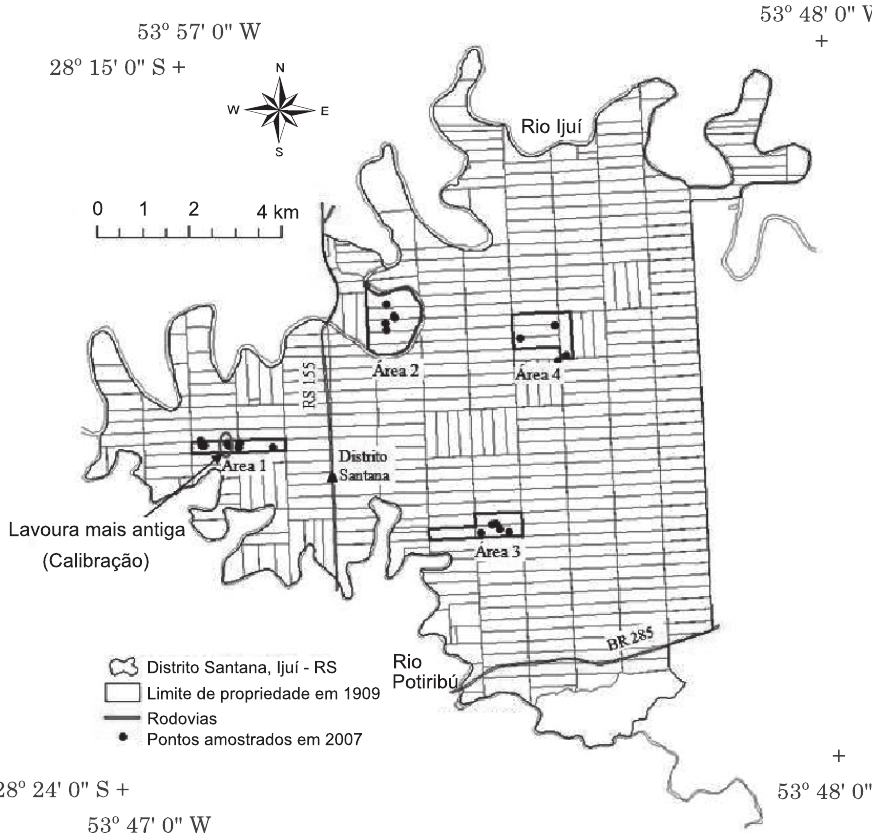
Figura 1. localização do distrito santana, ijuí – rs, e a distribuição espacial dos pontos amostrados em quatro áreas